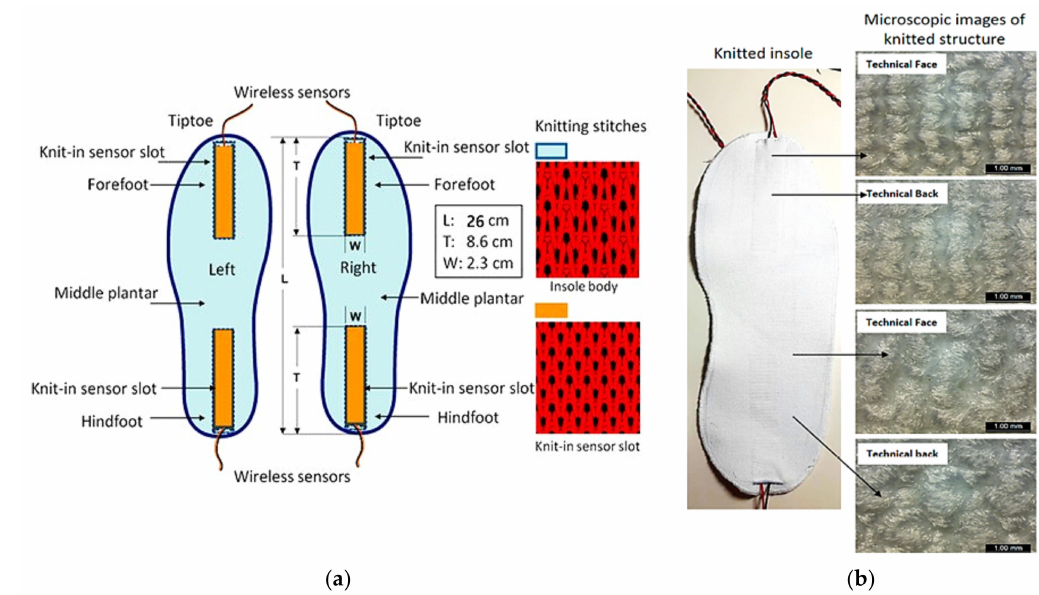
Figure 5. Schematic diagram of the self-powered intelligent insole detailing the fabric’s knitted motif ( a ) and the related prototype ( b ) Adapted from [38].